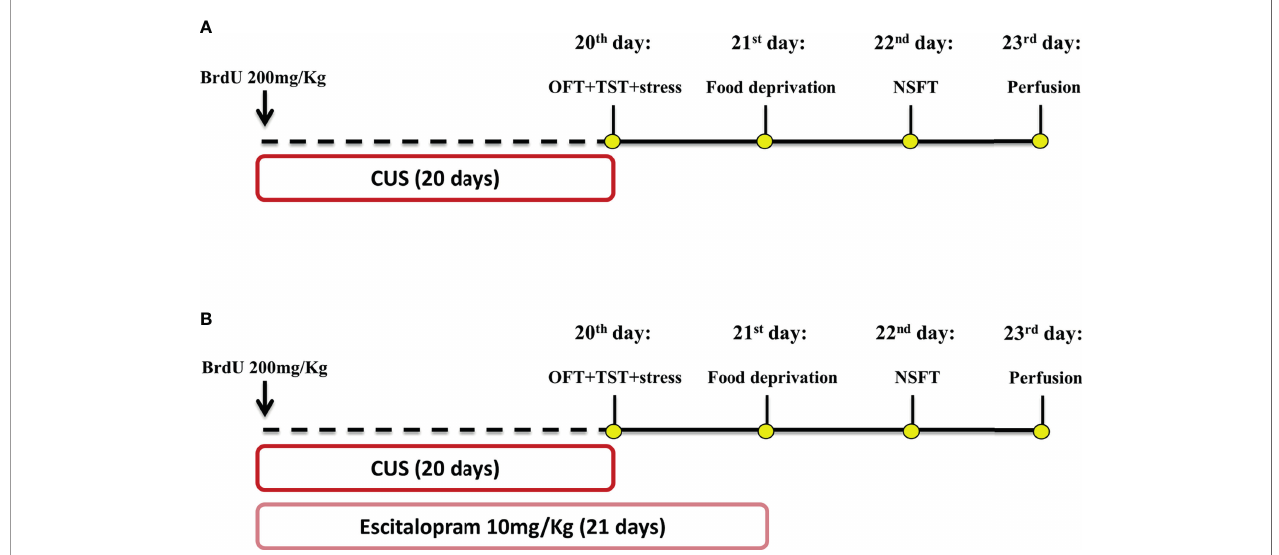
FIGURE 1 | Schematic representation of treatment and stress protocol dynamic and behavioral assessment time course. Animals received a single dose of BrdU 200 mg/Kg 1h before the CUS protocol start. Independent experimental groups were treated with ESC 10 mg/Kg by 21 days (B) while the other remained without pharmacological manipulation (A) . CUS protocol lasted 20 days and was proceeded by OFT and TST tests on 20 day, food deprivation on the 21 day and NSFT on 22 day. All animals were submitted to the perfusion protocol and had their brain collected for posterior analysis (A, B) . This fi gure was created by one of the